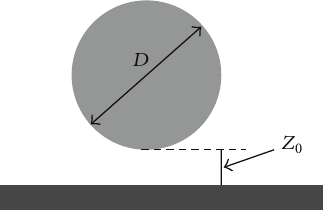
Figure 3: Schematic of adhesion between a particle and a surface.